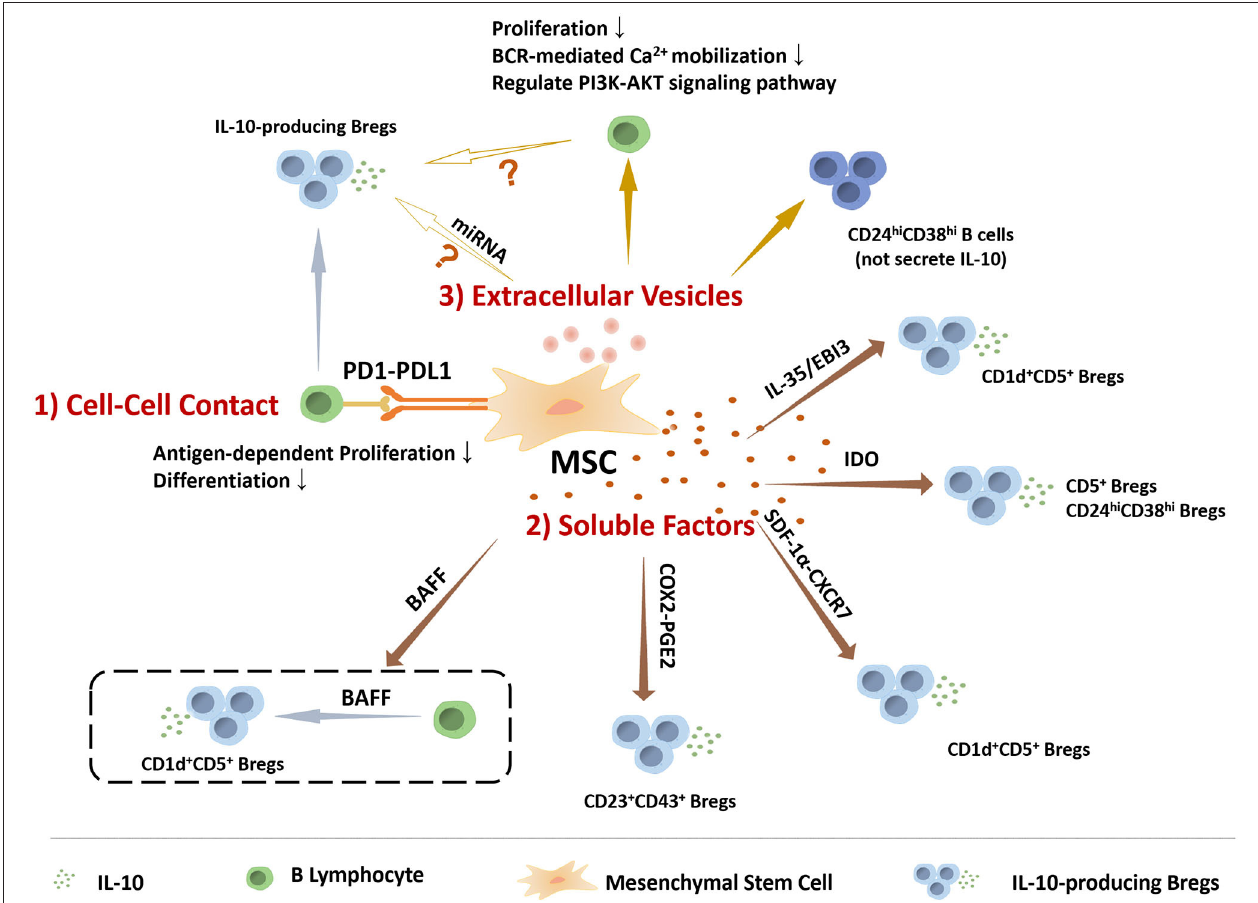
FIGURE 1 | The role of MSCs in regulating the IL-10 producing regulatory B cells. MSCs perform functions on modulating IL-10 producing regulatory B cells via many manners, including (1) Cell-to-cell contact: MSCs play roles in B cells via PD1-PDL1 pathway to inhibit antigen-dependent proliferation and differentiation, and induce Bregs. (2) Soluble factors: IL-10-producing Breg subsets, including CD5 + Bregs, CD24 high CD38 high Bregs, CD1d + CD5 + Bregs, and CD23 + CD43 + Bregs, are mediated by MSCs-secreting soluble factors. (3) Extracellular Vesicles: MSCs-EVs could inhibit B cell proliferation and BCR-mediated Ca 2 + mobilization, regulate PI3K-AKT signaling pathway in B cells that is critical for Breg cell development, and induce CD24 high CD38 high B cell subpopulation, a classic phenotype of Bregs, but without IL-10 production. Based on the current data, MSCs-EVs might be involved in MSCs regulating IL-10 producing B cells.